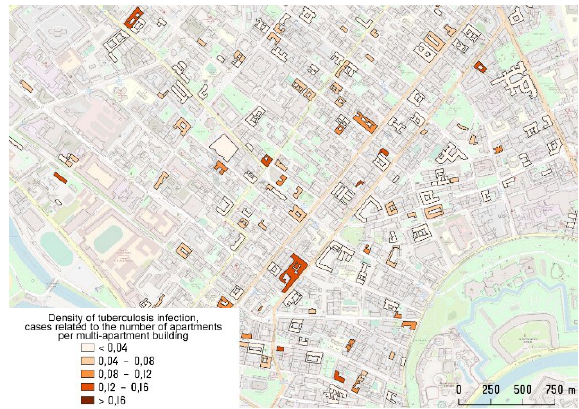
Figure 4 . Example of tuberculosis infection density map (cases